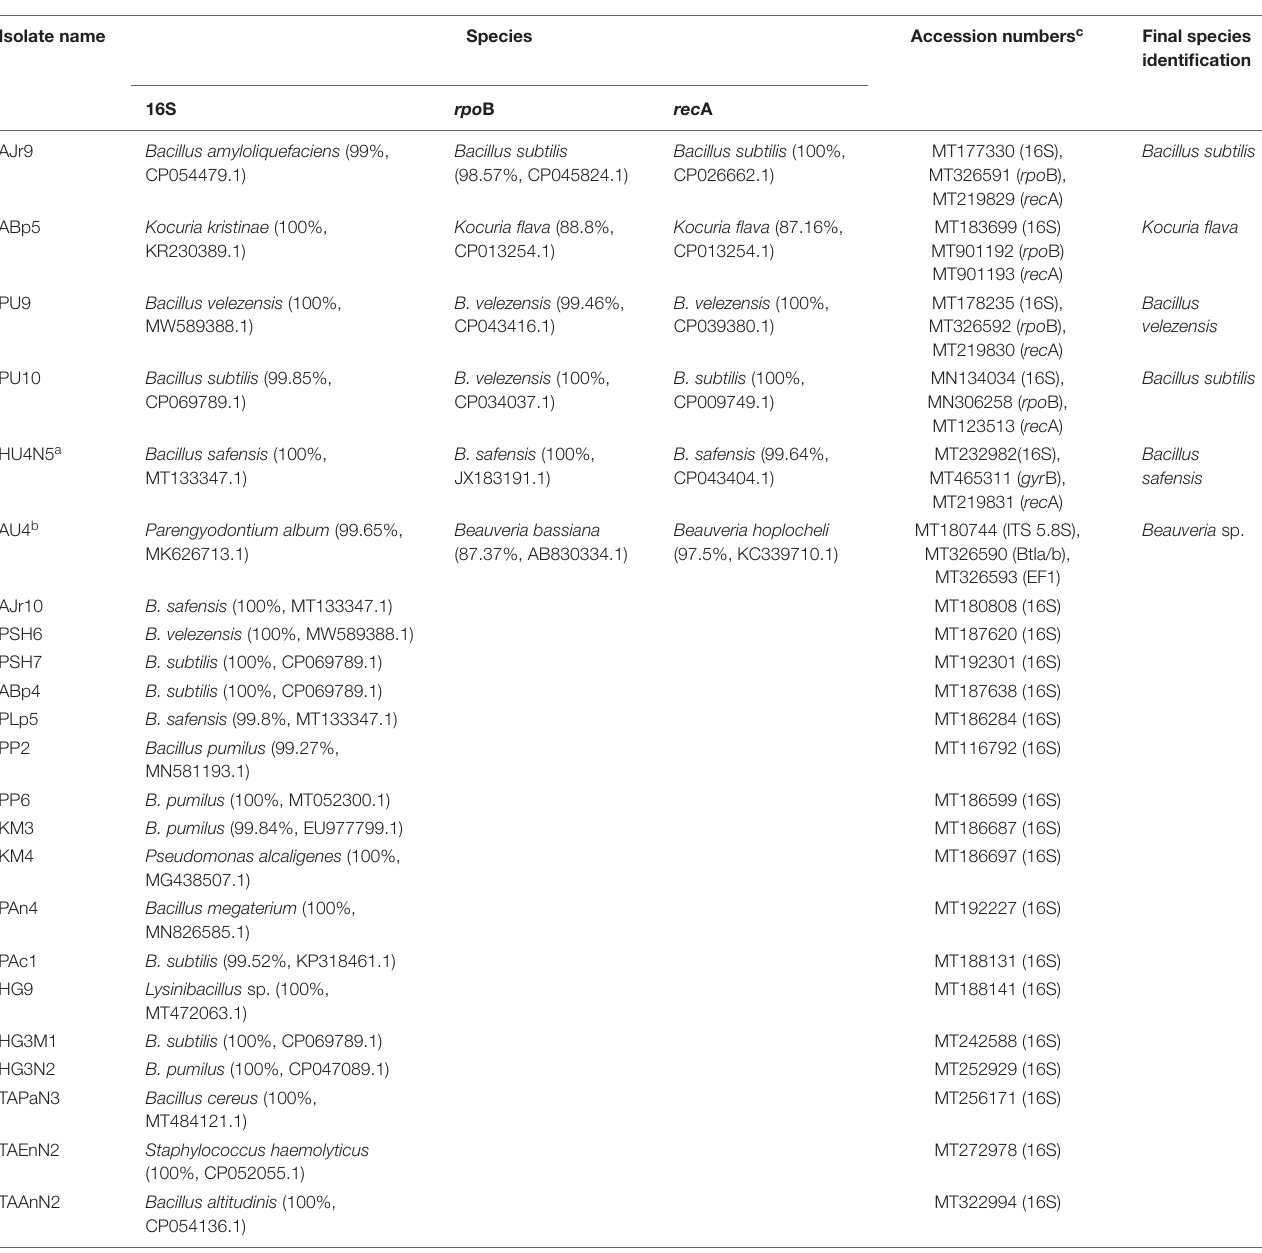
TABLE 3 | Identification of the highly active endophytic bacteria and